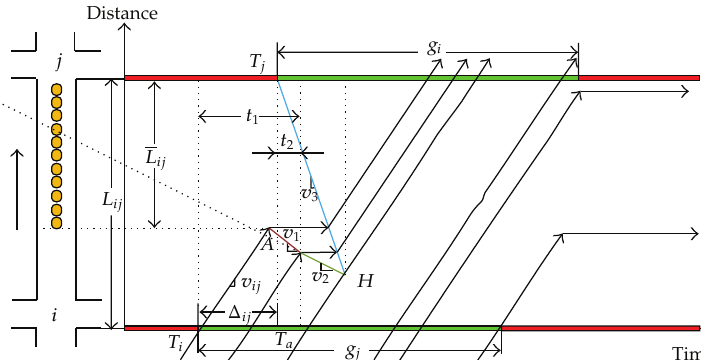
Figure 3: Tra ffi c flow temporal-spatial graph at saturated arterial adjacent